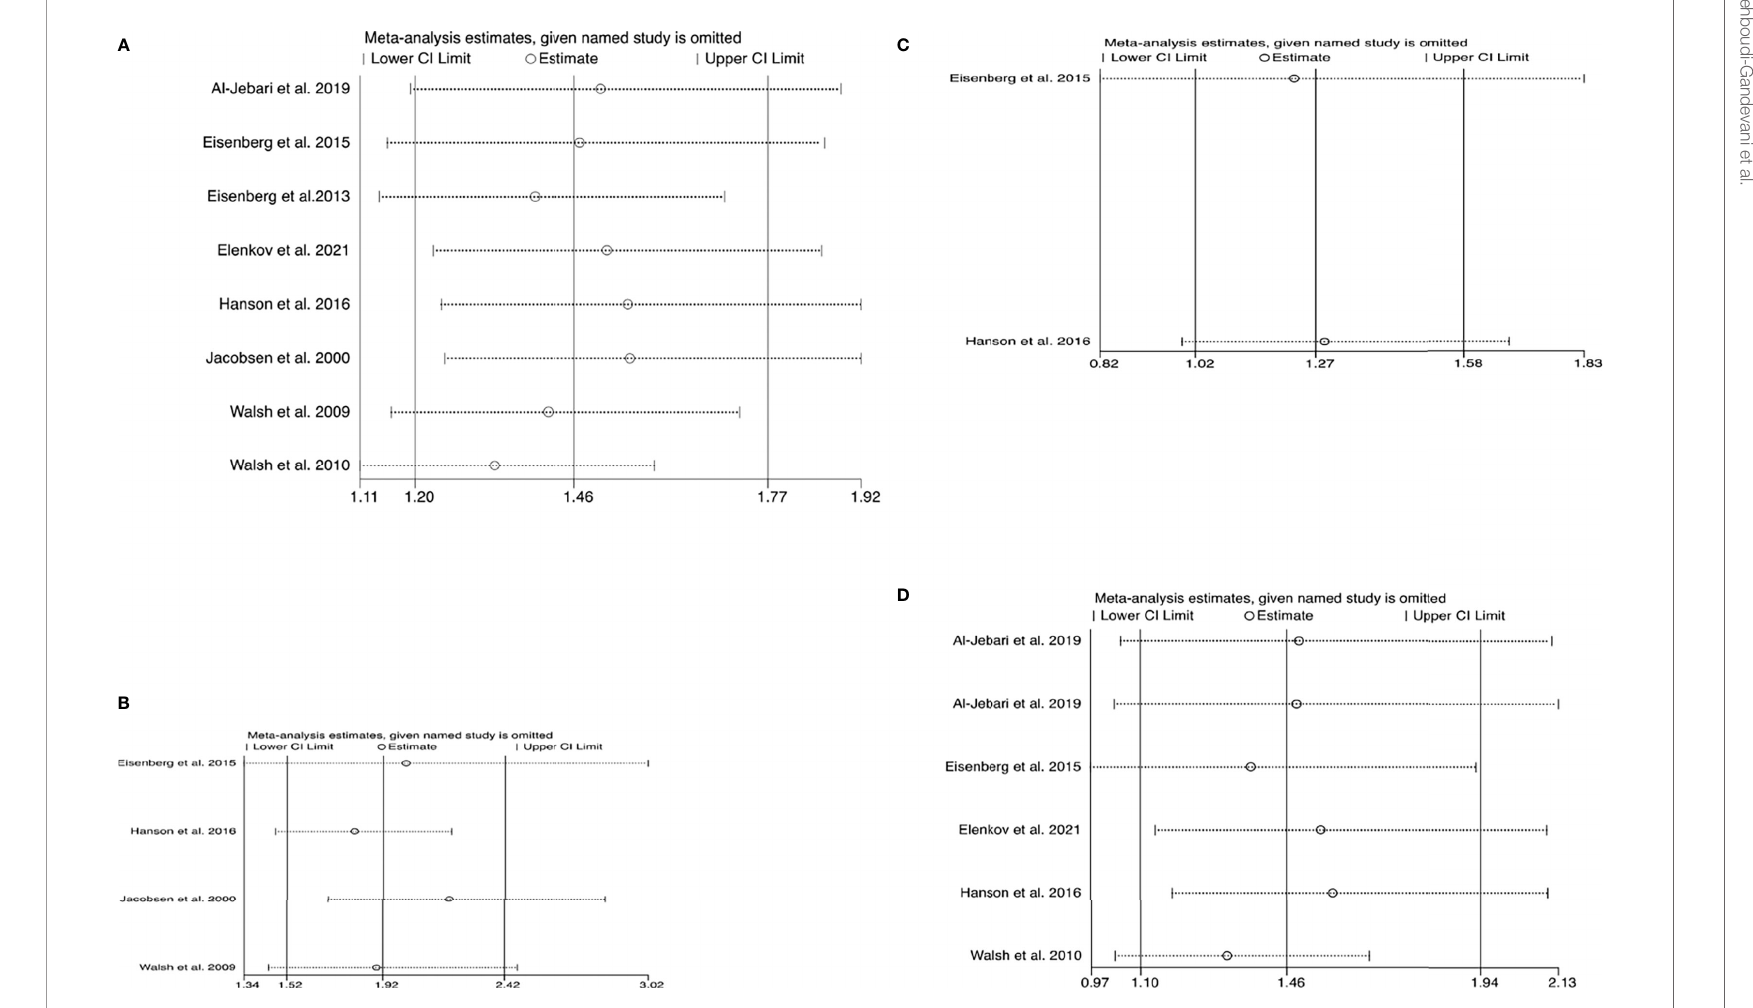
FIGURE 3 | Plots of sensitivity analysis results (A) all cancers (B) testicular cancer (C) melanoma (D) prostate cancer. These graphs show the in fl uence of each individual study on the overall meta-analysis summary estimate. Accordingly, the results of an in fl uence analysis in which the meta-analysis is re-estimated omitting each study in turn has been shown. They provide the visual results, naming the omitted study on the left margin and omitted meta-analytic summary statistics as horizontal con fi dence intervals on the right side. The full, combined results have been shown as the solid vertical lines. For interpretation, an individual study is suspected of having an excessive in fl uence if the point estimate of its omitted analysis lies outside the con fi dence interval of the combined analysis. (A) Sensitivity analysis plot for the composite outcome of cancers. (B) Sensitivity analysis plot for testicular cancer. (C) Sensitivity analysis plot for melanoma. (D) Sensitivity analysis plot for prostate